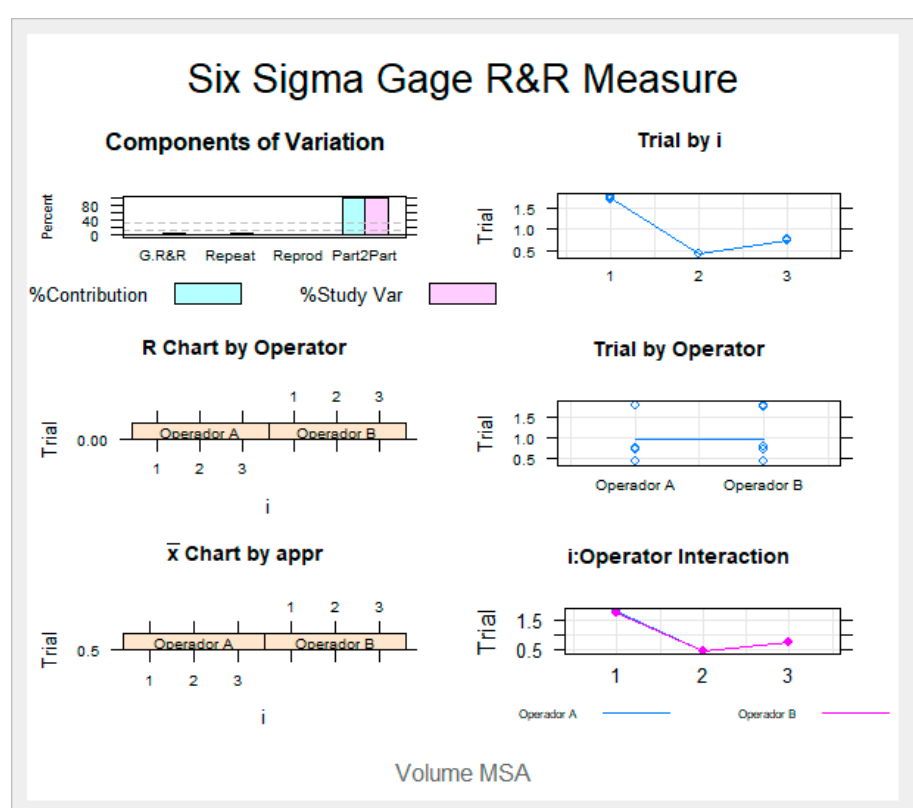
Figure 13. Measurement system analysis related to the volume measurement with a chart of the contribution of each component to the total variance (Components of Variation), a mean control chart and a range control chart (R Chart by Operator and x Chart by appr), every measurement point in the graph (Trial by I and Trial by Operator), and the interactions between the operators ( i ): Operator interaction).